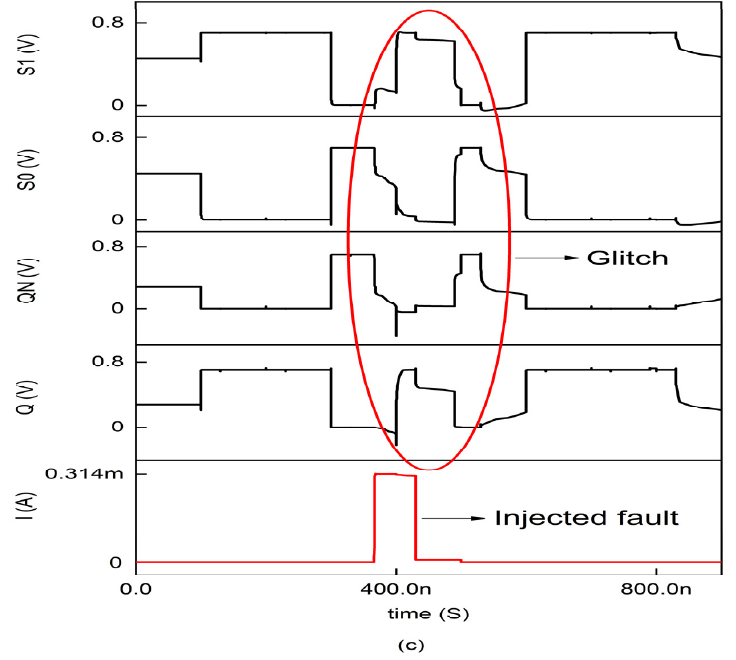
Figure 12. Timing and simulation of 10T where the fault is injected at node QN for varying Isource: ( a ) 274 mA ( b ) 294 mA and ( c ) 314 mA.